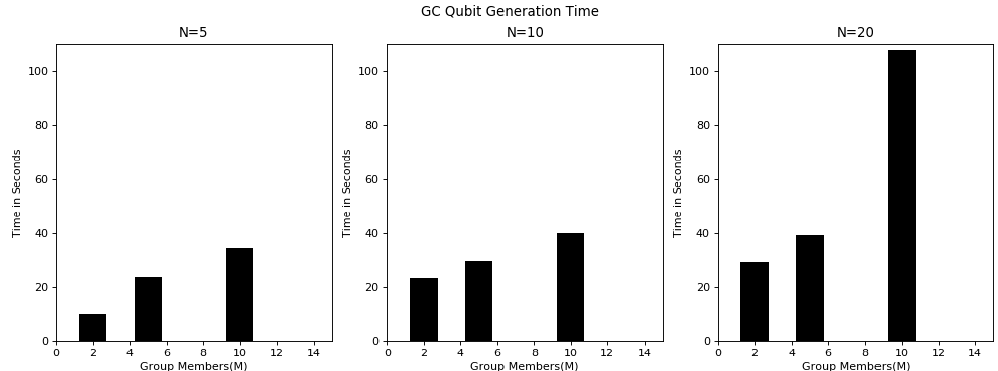
Figure 7. Time for qubit generation by GC.